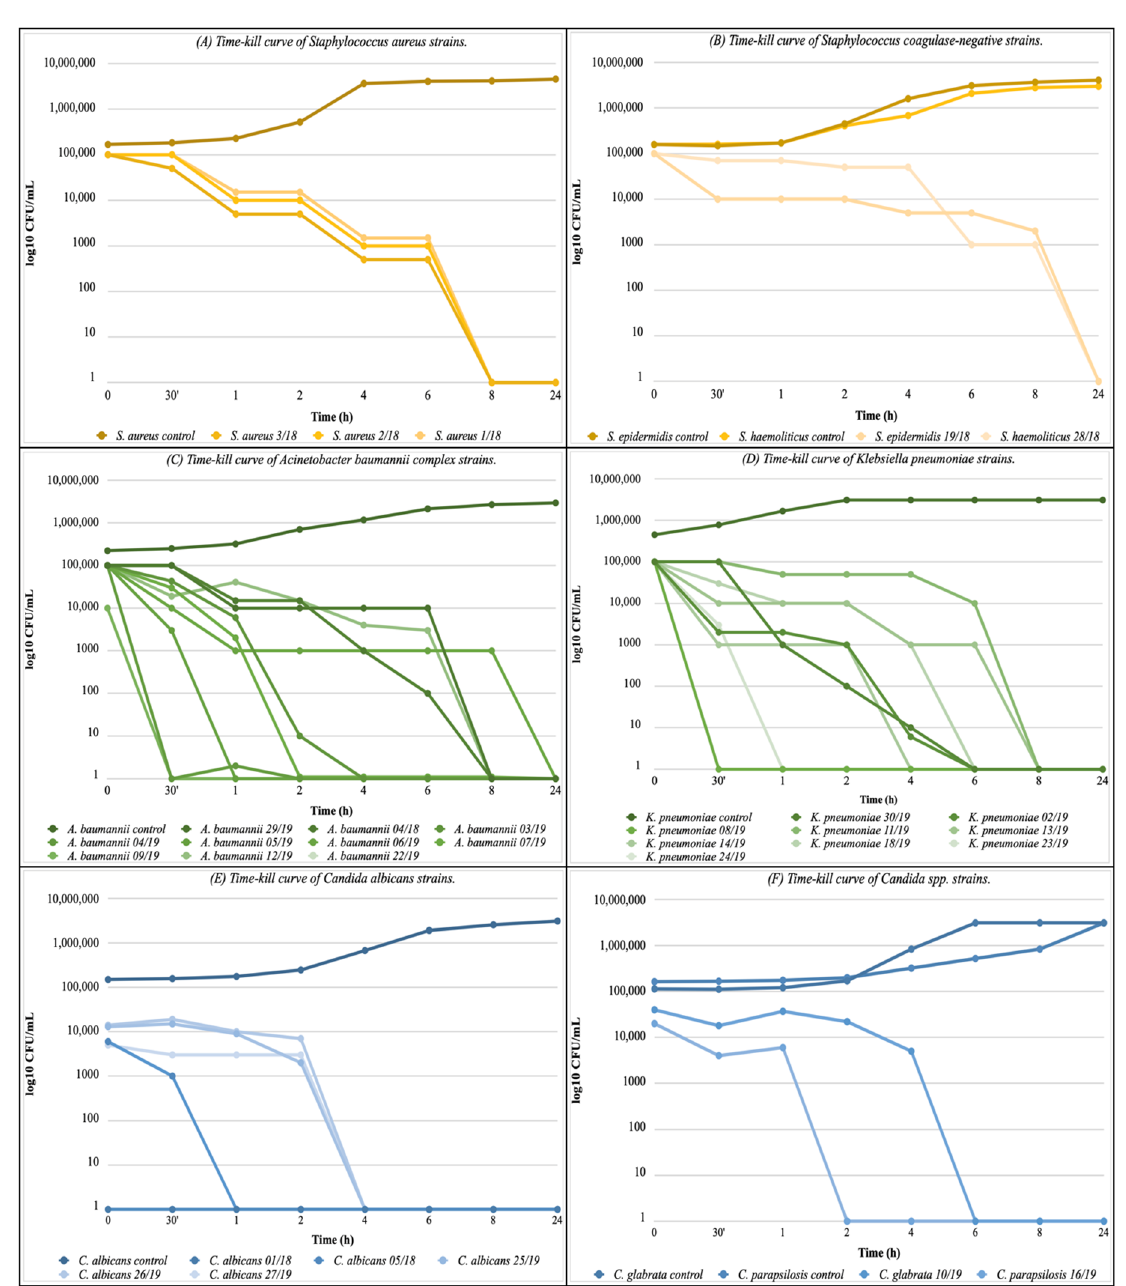
Figure 2. Time-kill curves of distilled extract of bergamot 1 × MBC against: ( A ) Staphylococcus aureus strains; ( B ) Staphylococcus coagulase-negative strains; ( C ) Acinetobacter baumannii complex strains; ( D ) Klebsiella pneumoniae strains; ( E ) Candida albicans strains; ( F ) Candida spp.